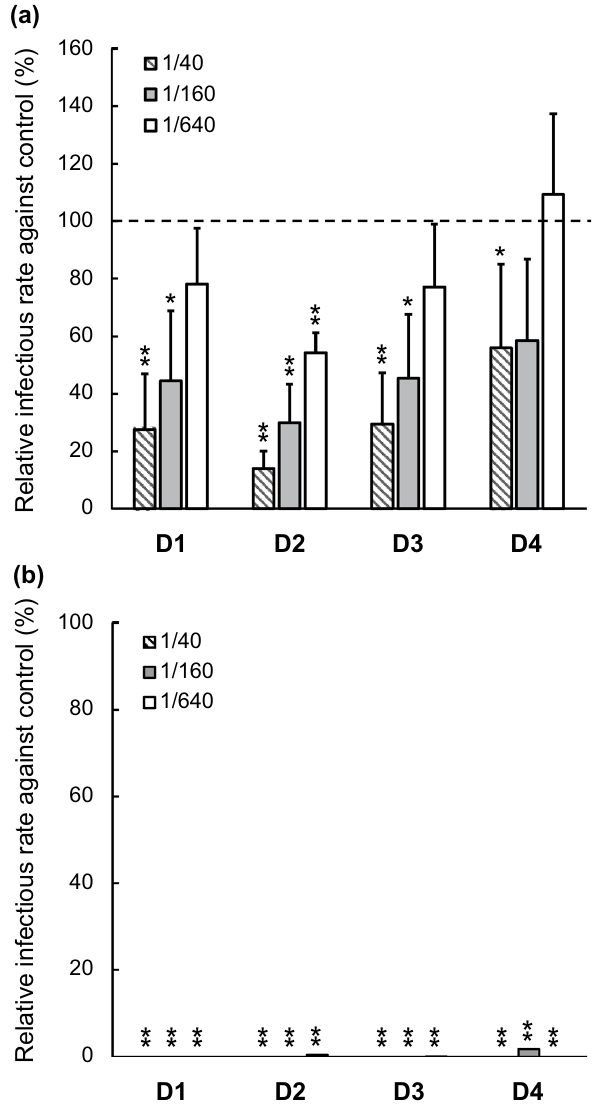
Figure 4. Evaluation of neutralization activity of mice sera immunized by tetravalent DENV-LPs. Infectious rates of DENV SRIPs in the presence of control sera were shown in the Supplementary Fig. 4. ( a ) Neutralizing activity of immunized sera against DENV-1 (D1), -2 (D2), -3 (D3) and -4 (D4) was individually evaluated by relative infectious rate using SRIPs assay based on the average of control, non-immunized mouse sera and was expressed as a relative infectious rate against control (100%) for each serum dilution. Dilution rates of test sera were 1:40 (diagonal lined bars), 1:160 (gray bars) and 1:640 (white bars). Statistical analyses for comparison between infectious rates of immunized (n = 4) and control sera (n = 5) were performed by Welch’s test (* p < 0.05, ** p < 0.01). Error bars were drawn based on standard deviation. The dotted line indicates 100% of relative infectious rate based on the mean infectious rate of the control sera. ( b ) Neutralizing activity of Zika virus NS1 IgG-positive human serum used as a positive control was evaluated as described in ( a ). The positive control serum was tested in quadruplicate and statistically compared with negative control sera similarly (** p <